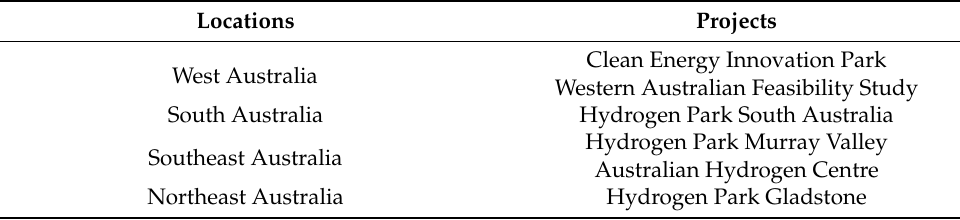
Table 3. Australian renewable gas projects [103].